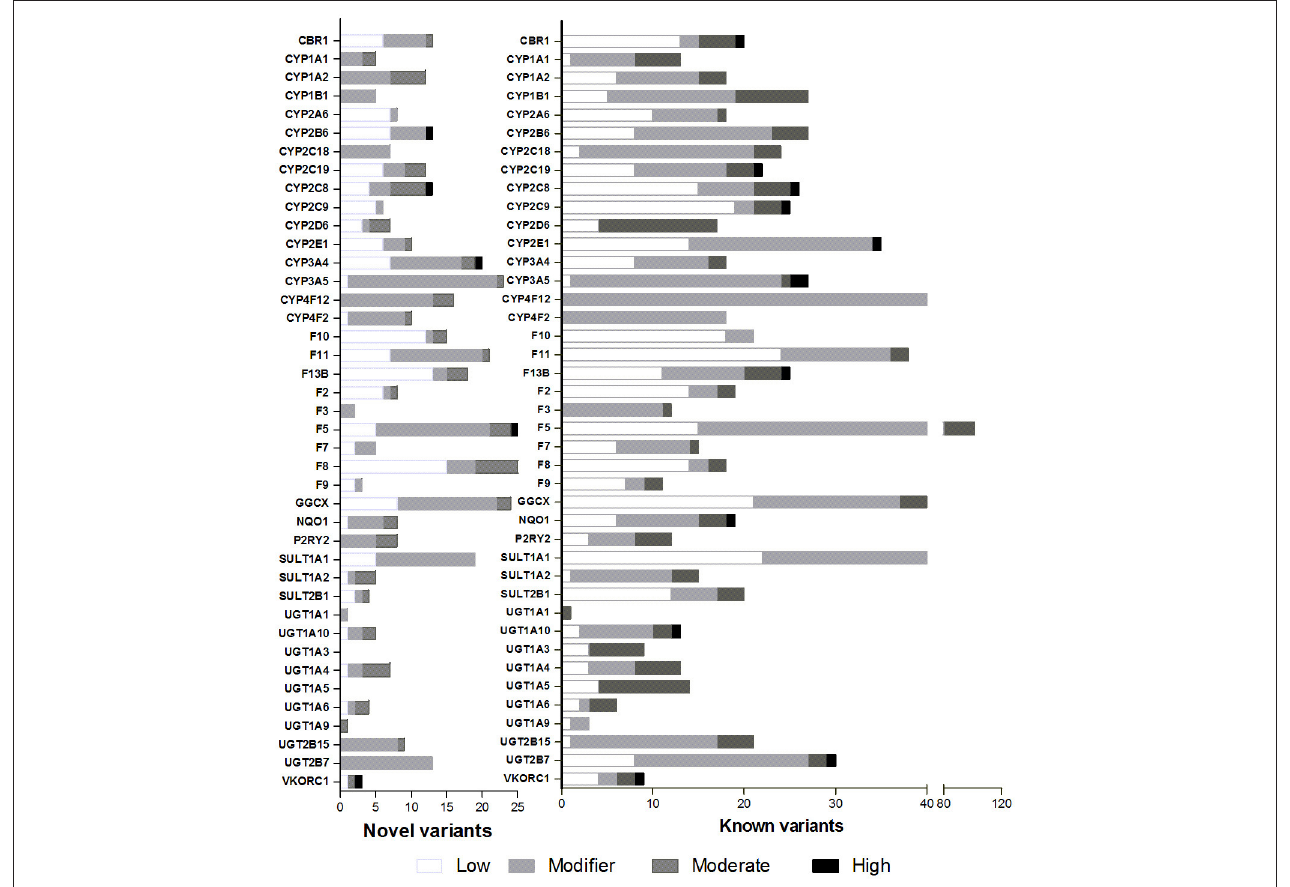
FIGURE 1 | Proportion of novel and known variants. Functional impact determined in-silico is depicted in white for low impact, light gray for modifier, dark gray for moderate impact, and black for high